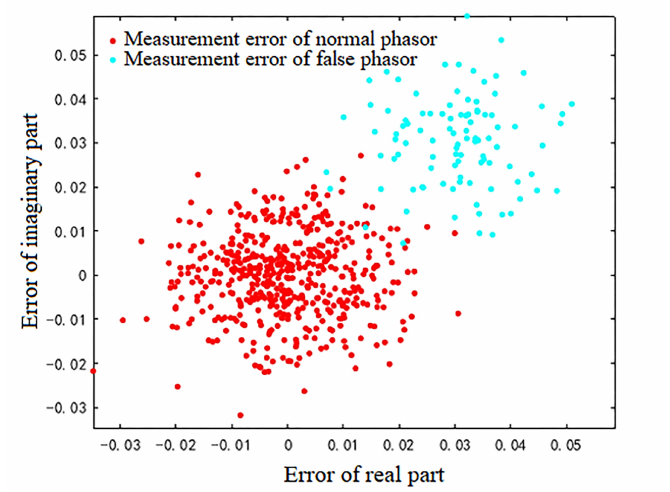
Figure 1. The actual distribution of phase measurement errors after injecting false